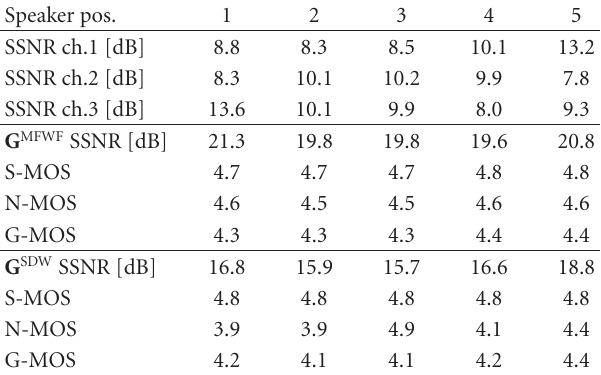
Table 3: Simulation results for the system in the conference environment with with T 60 = 0 . 25